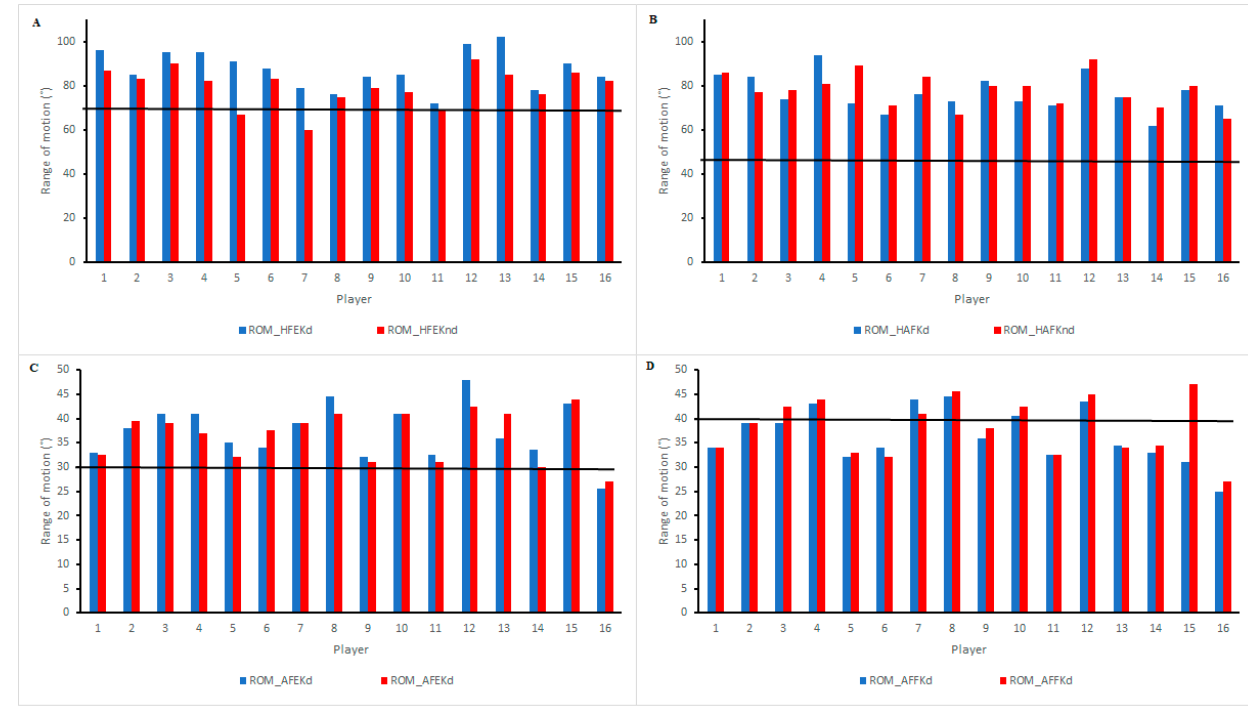
Figure 2. Individual range of movement values (( A ) flexion with extended knee; ( B ) hip abduction with flexed knee; ( C ) ankle flexion with extended knee; (D) ankle flexion with flexed knee). ROM: range of motion; D: dominant; ND: non-dominant; HFEK: hip flexion with extended knee; HAFK: hip abduction with flexed knee; AFEK: ankle flexion with extended knee; AFFK: ankle flexion with flexed knee.